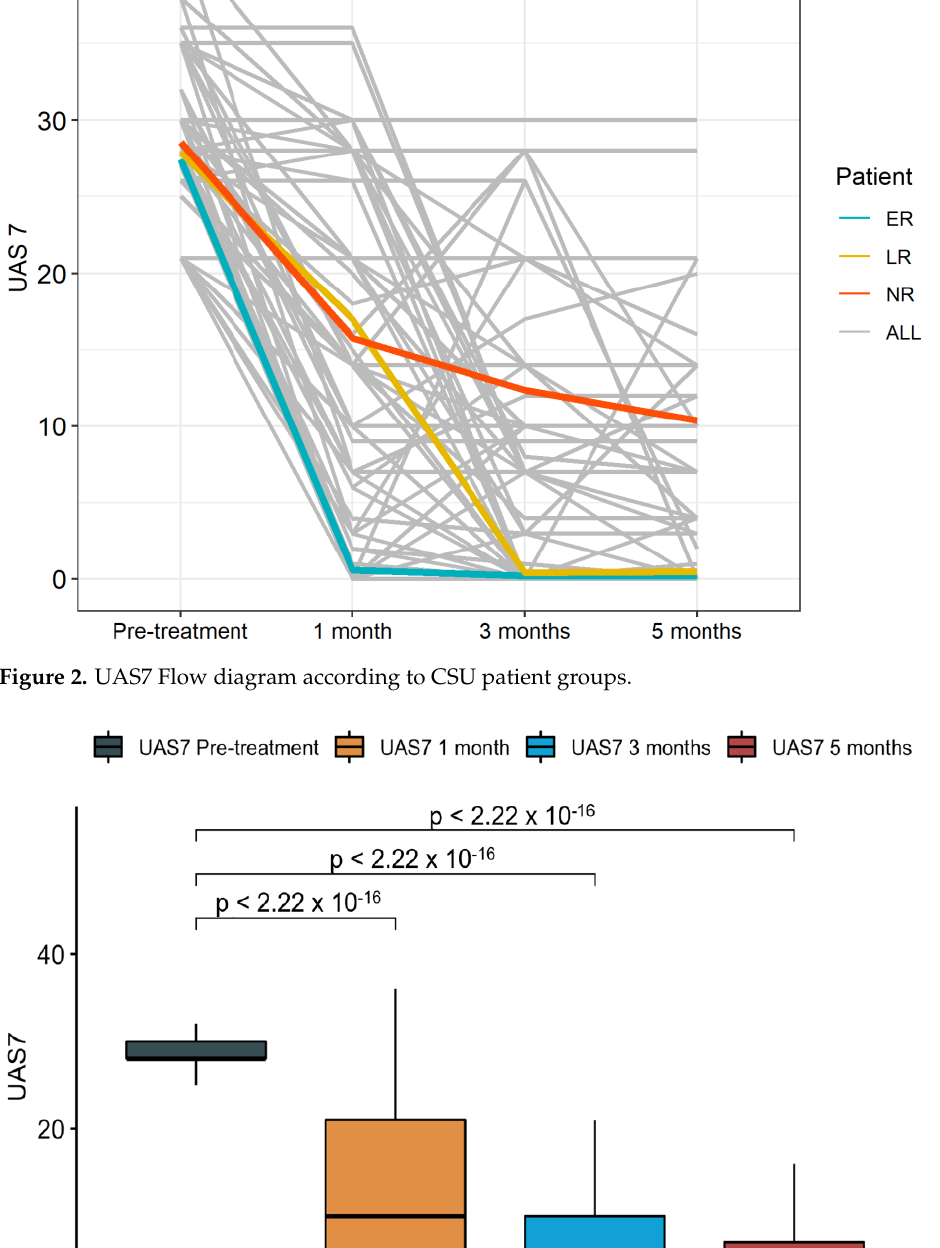
Figure 3. Response to omalizumab in South Italian CSU patients.